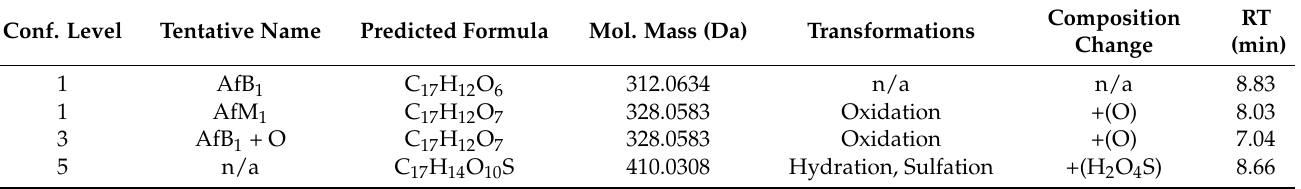
Table 4. Features detected in ‘expected compounds search’ after filtering and